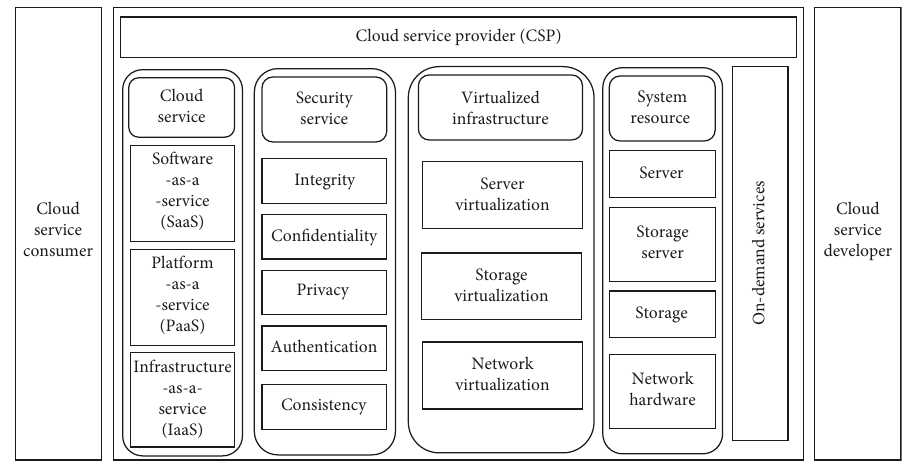
Figure 1: Architecture of the multitier cloud